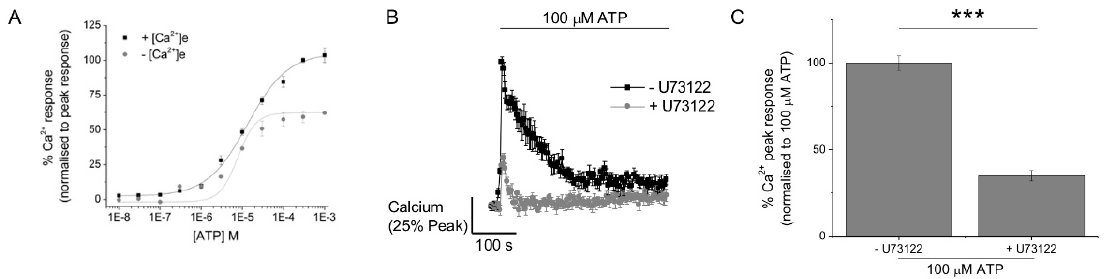
Figure 2. ATP evokes metabotropic and ionotropic Ca 2+ responses in M-CSF differentiated human macrophage. ( A ) Averaged ( N = 3) ATP concentration response performed in the presence (1.2 mM) and absence (no Ca 2+ , 2 mM EGTA) extracellular Ca 2+ . ( B ) Averaged ( N = 3) intracellular peak Ca 2+ responses evoked by 100 µ M ATP in the absence and presence of U73122 (10 µ M). Mean peak responses are given in ( C ) ** p < 0.01. All data is mean ± SEM; hypothesis testing by t -test.